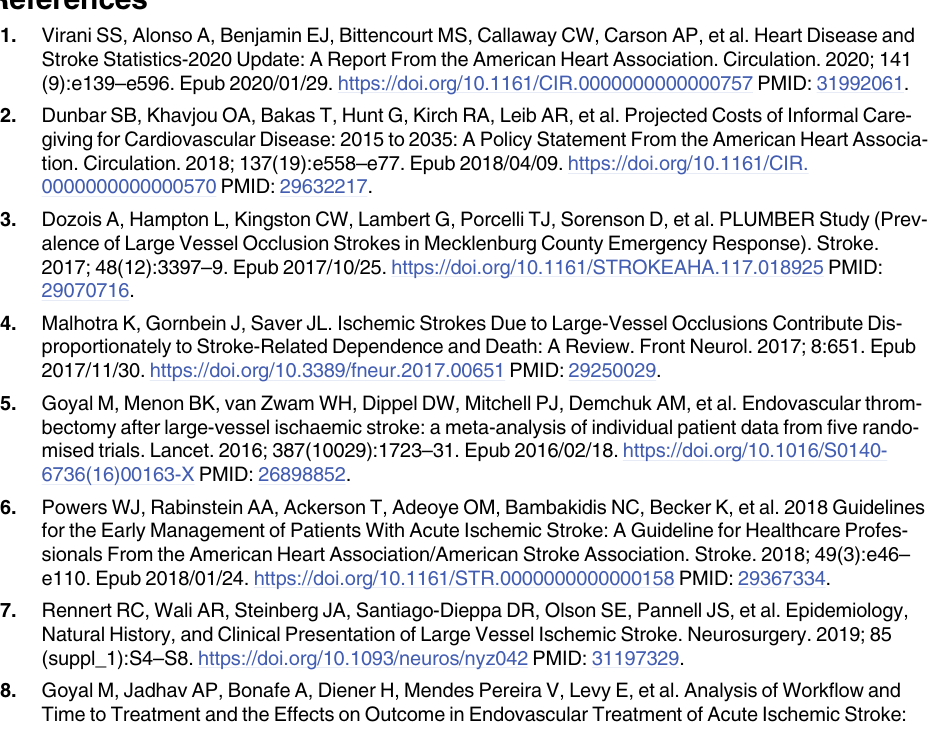
S1 Table. Emergent transfers using the conventional transfer